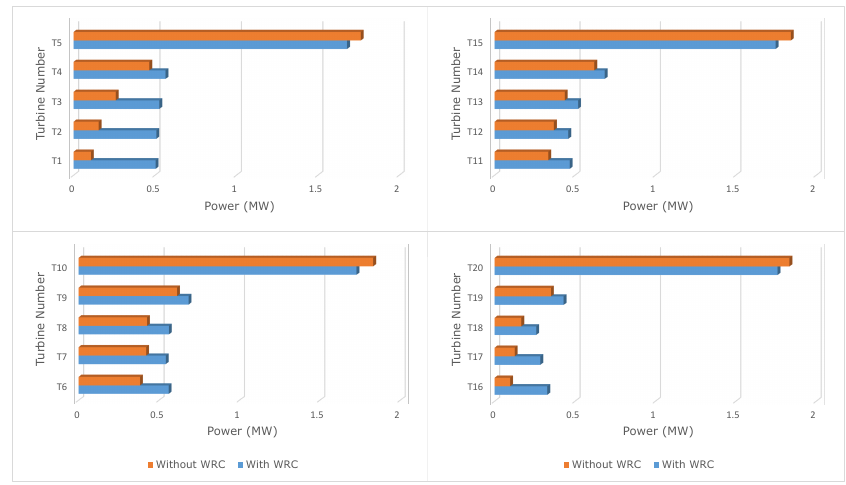
Figure 15. Power produced by individual turbine with and without WRC.